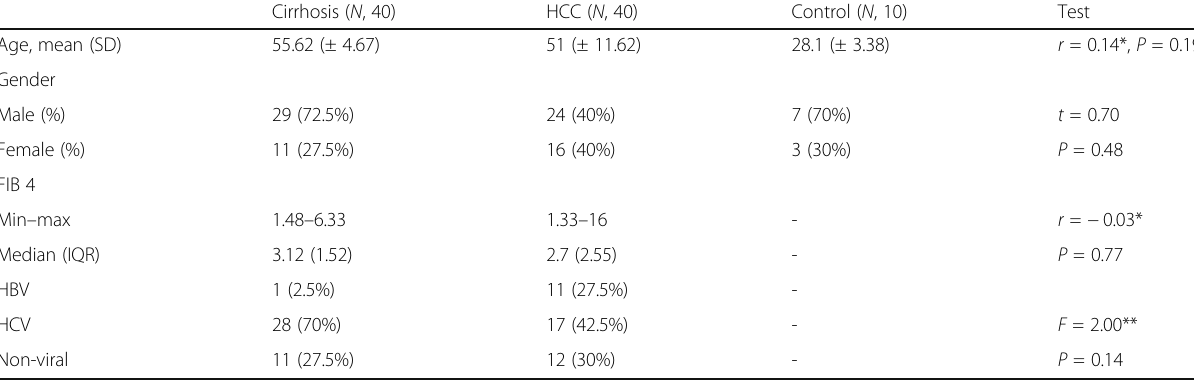
Table 1 Socio-clinical criteria of the study population and relationship with α 2 δ 1 Cirrhosis ( N , 40) HCC ( N , 40) Control ( N , 10)